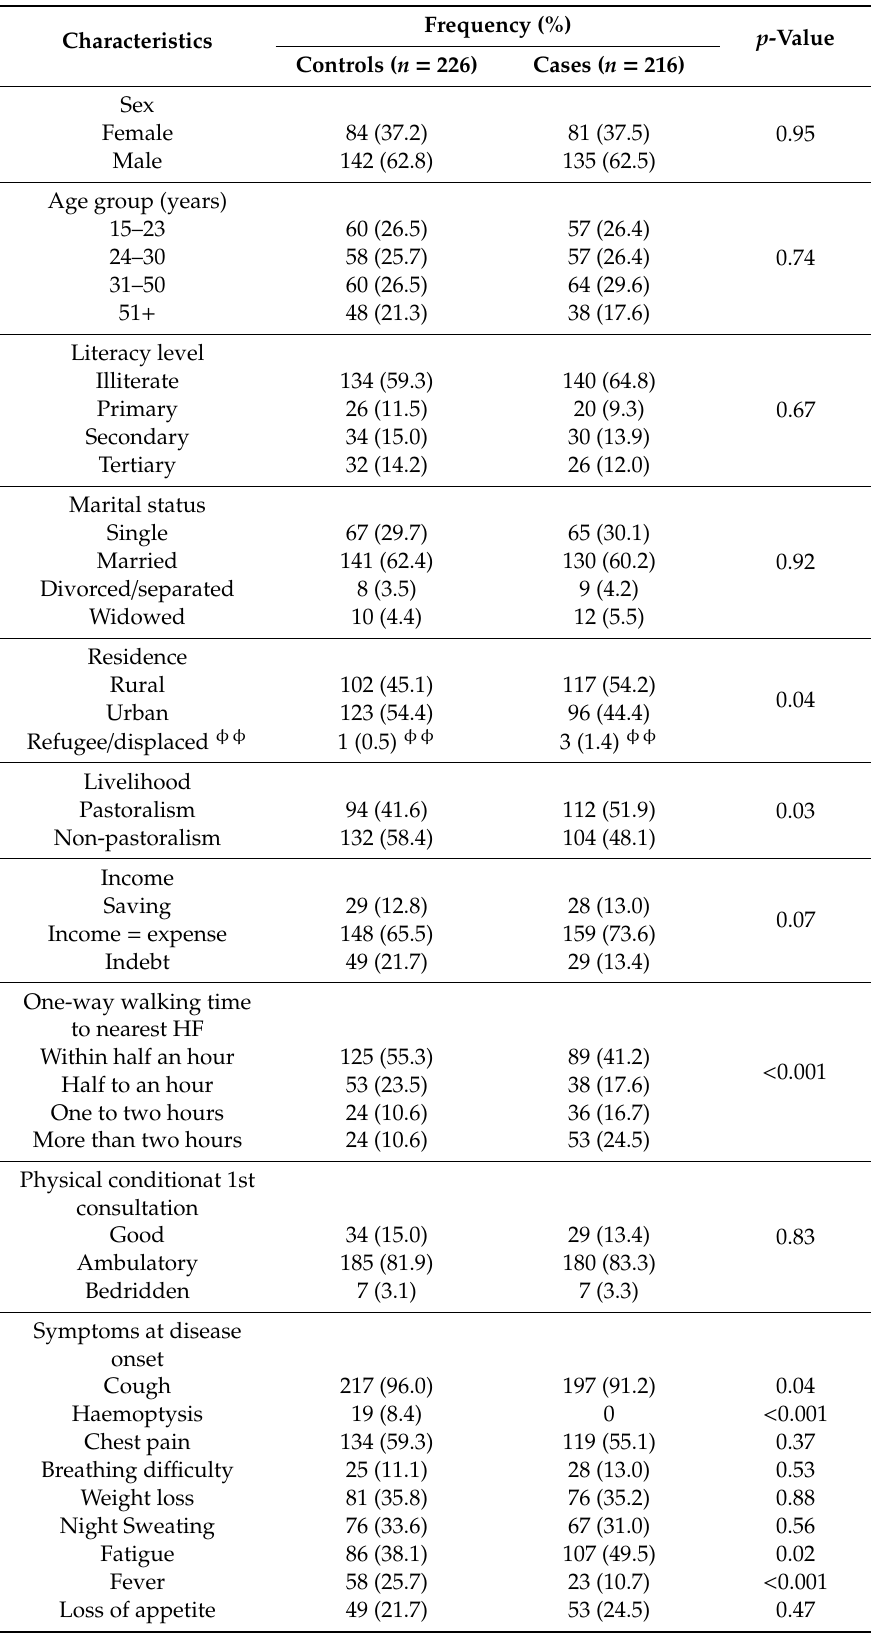
Table 1. Clinical characteristics of pulmonary tuberculosis (TB) patients in Somali Region, Ethiopia, December 2017 to October 2018 ( controls = 226, cases =